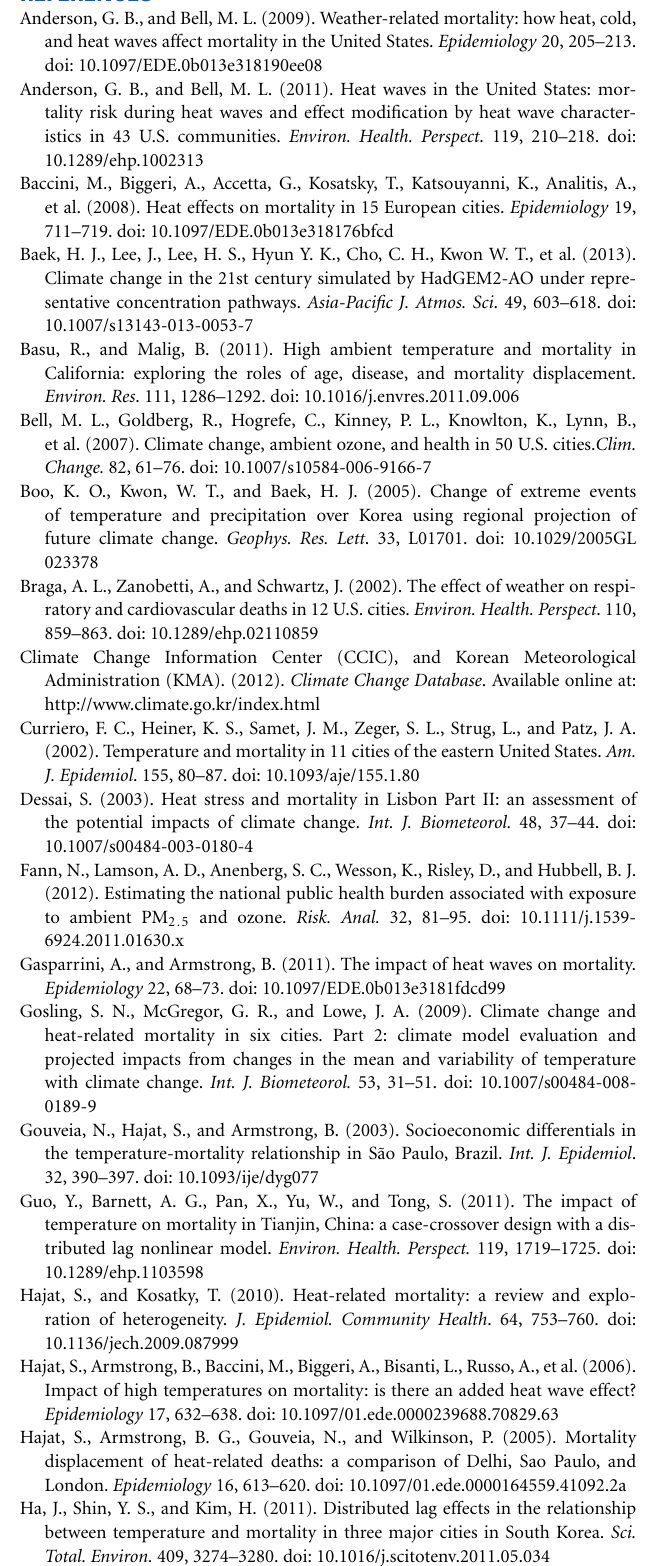
Table S1 | Summary of simulated temperature under two RCP a